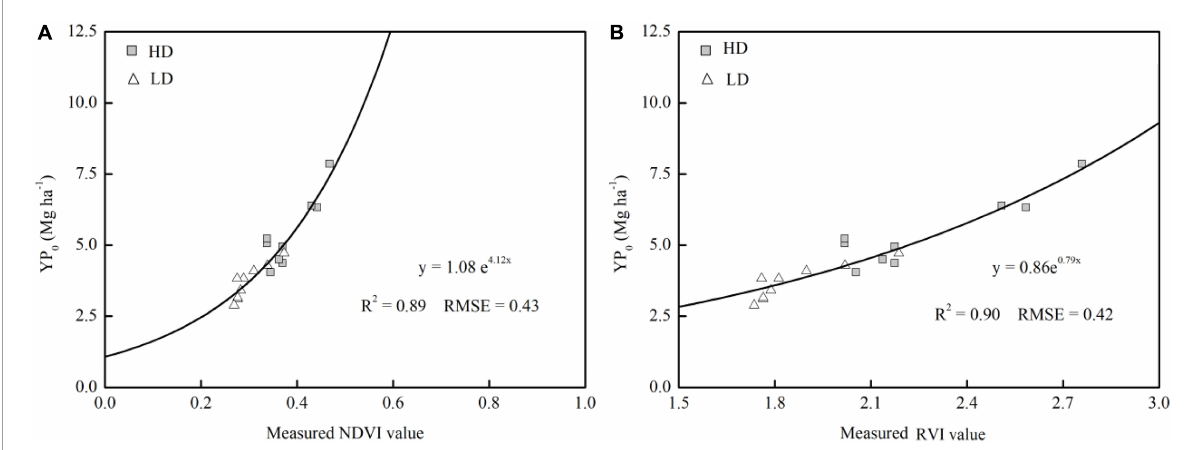
FIGURE3 Relationship between in-season estimates of yield potential without additional N topdressing (YP 0 ) at the rosette stage calculated using the normalized difference vegetation index (NDVI) (A) and the ratio vegetation index (RVI) (B) in Years I, II, and